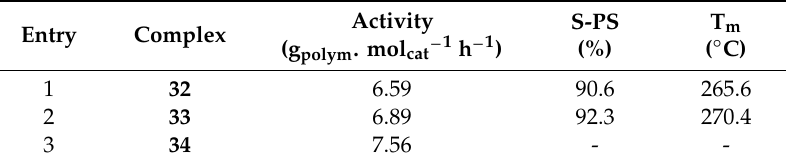
Table 10. Polymerization of styrene catalyzed by 32–34 /MAO systems [16].